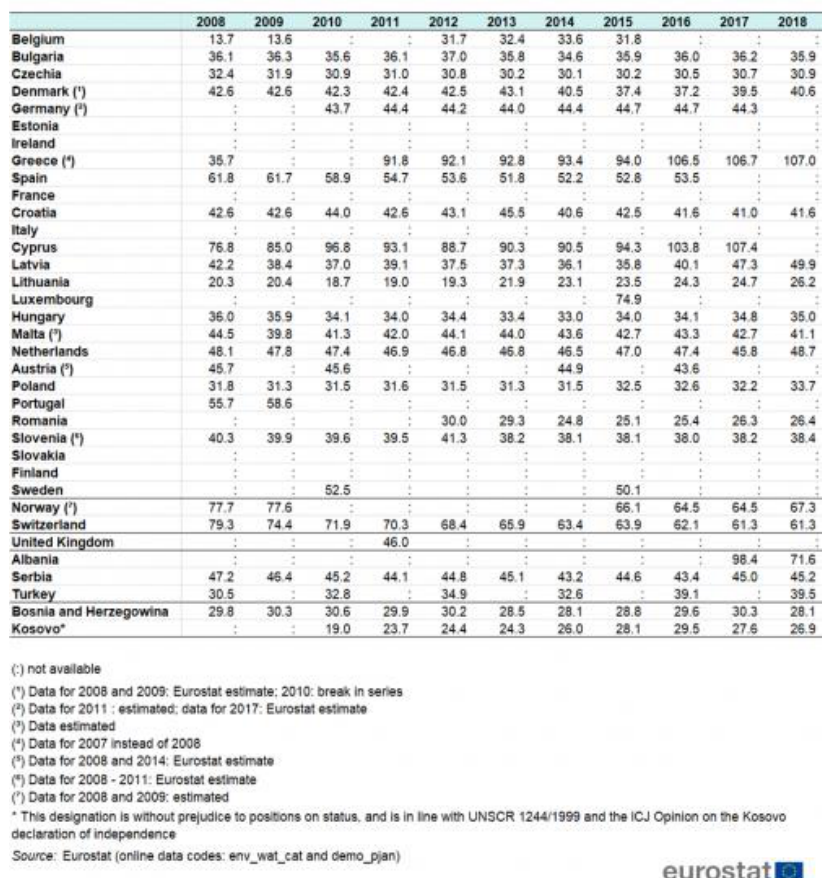
Figure A4. Household water use in the EU, 2008–2018, m 3 /inhabitant. Source: Water statistics—Statistics Explained (europa.eu) (accessed on 20 May 2021).